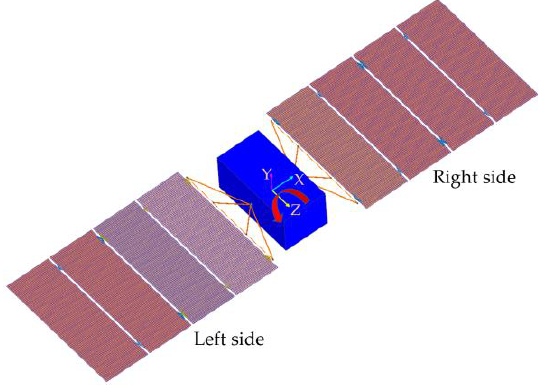
Figure 6. Satellite system with flexible panels. Table 4. First 30 natural frequencies of Panel 1 and Panel 4.